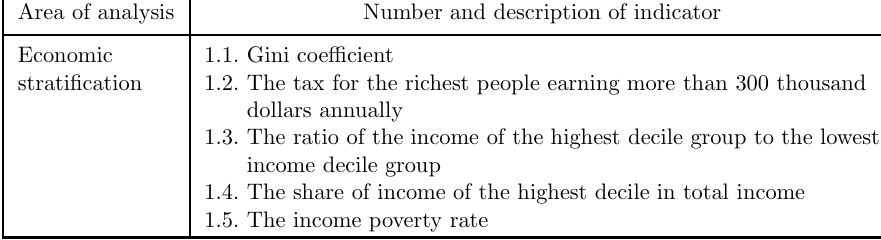
Selected indicators of differentiation Area of analysis Number and description of